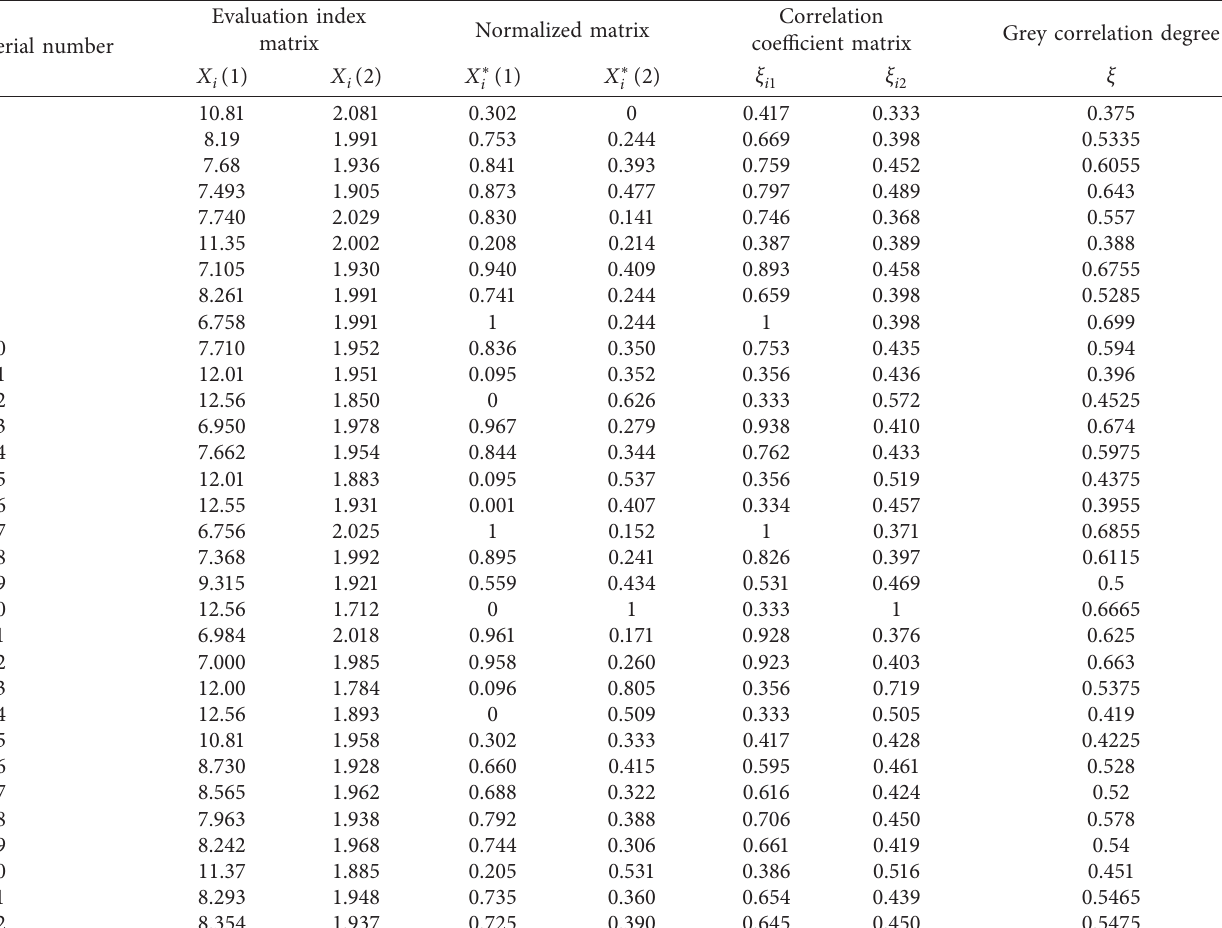
Table 7: Evaluation index matrix, correlation coefficient matrix, and grey correlation degree.